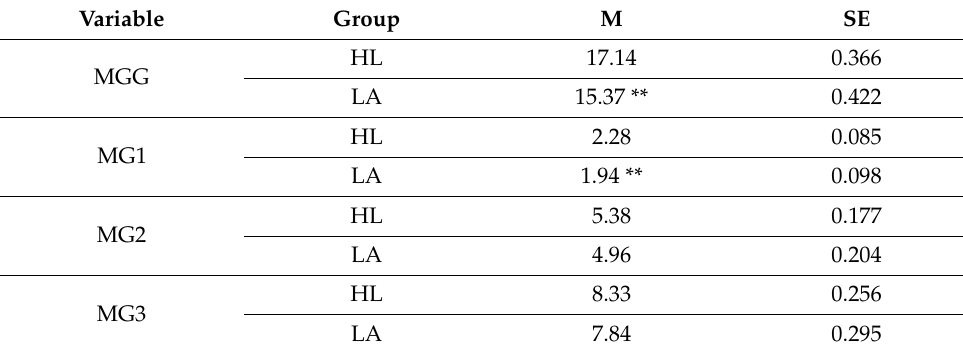
Table 2. Milk yield (kg) traits of cows ( n =